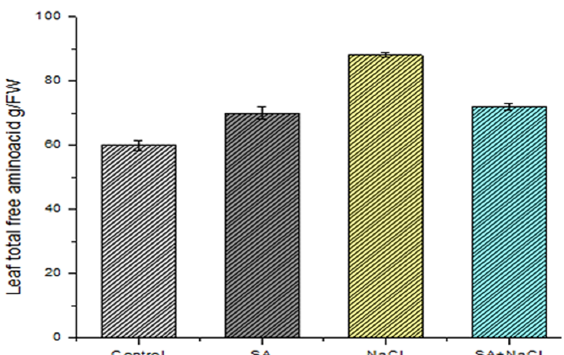
Figure 5. Leaf total free amino acid content: individual and combined effect of salinity and SA on leaf total free amino acid content. X axis -treatment group; Y axis - concentration of free amino acid (gram/ fresh weight) Values are expressed as mean ± SD, n=3 in each group.